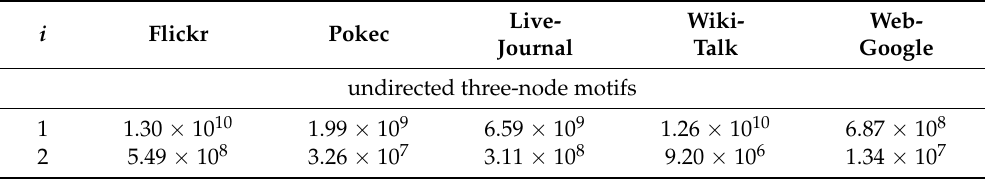
Table 3. Real values of three-node undirected motif frequencies ( i is the motif ID).